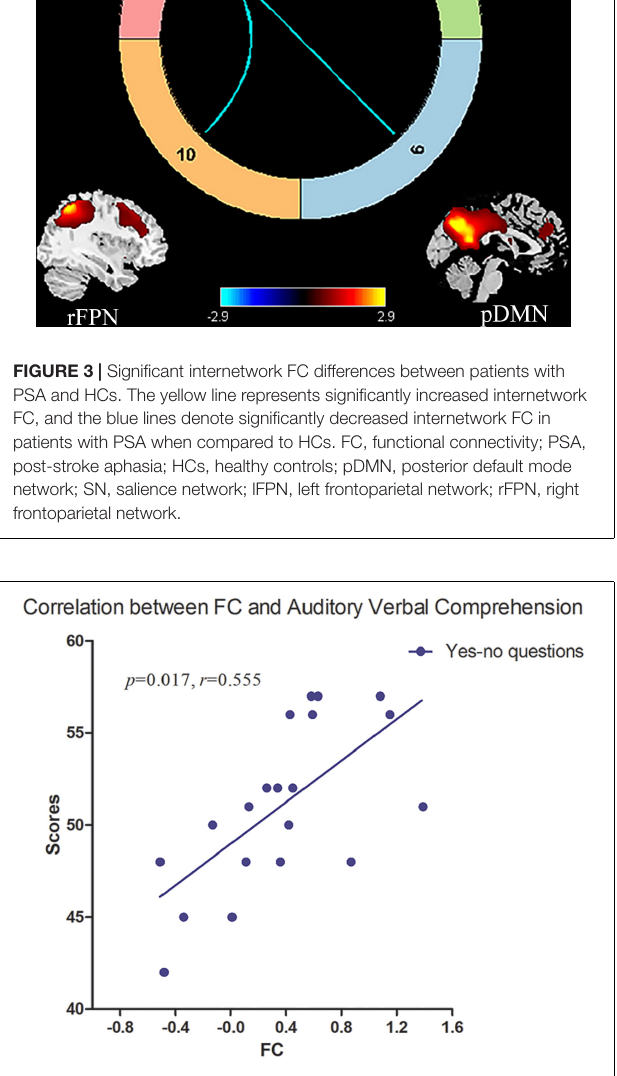
FIGURE 4 | The strength of FC between lFPN and rFPN was positively correlated with Yes/No questions ( p = 0.017, r = 0.555). FC, functional connectivity; lFPN, left frontoparietal network; rFPN, right frontoparietal